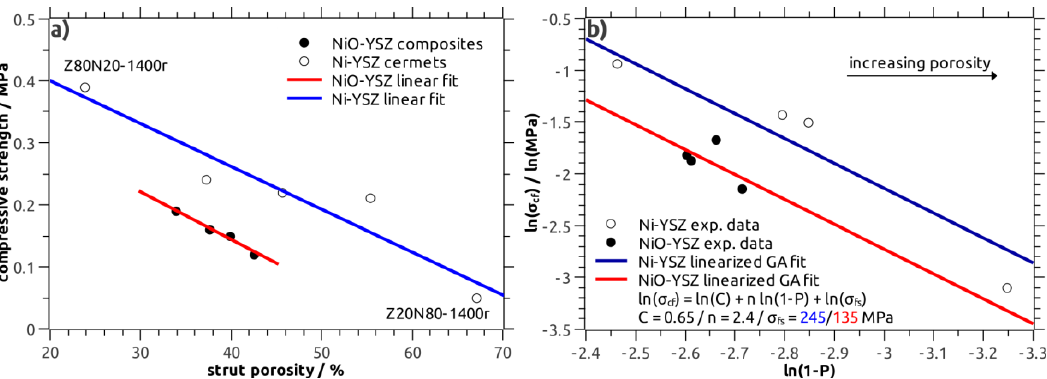
Figure 7. ( a ) Correlation between the compressive strength and the strut porosity in NiO–YSZ composites (filled symbols, red line) and Ni–YSZ cermets (open symbols, blue line); ( b ) Gibson–Ashby (GA) fit of the strength data obtained from NiO–YSZ and Ni–YSZ composites.